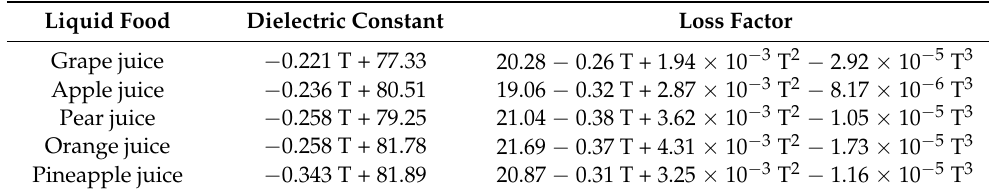
Table 4. Regression analysis of dielectric constants and dielectric loss factors of liquid food versus temperature T ( ◦ C) at 2.45 GHz.